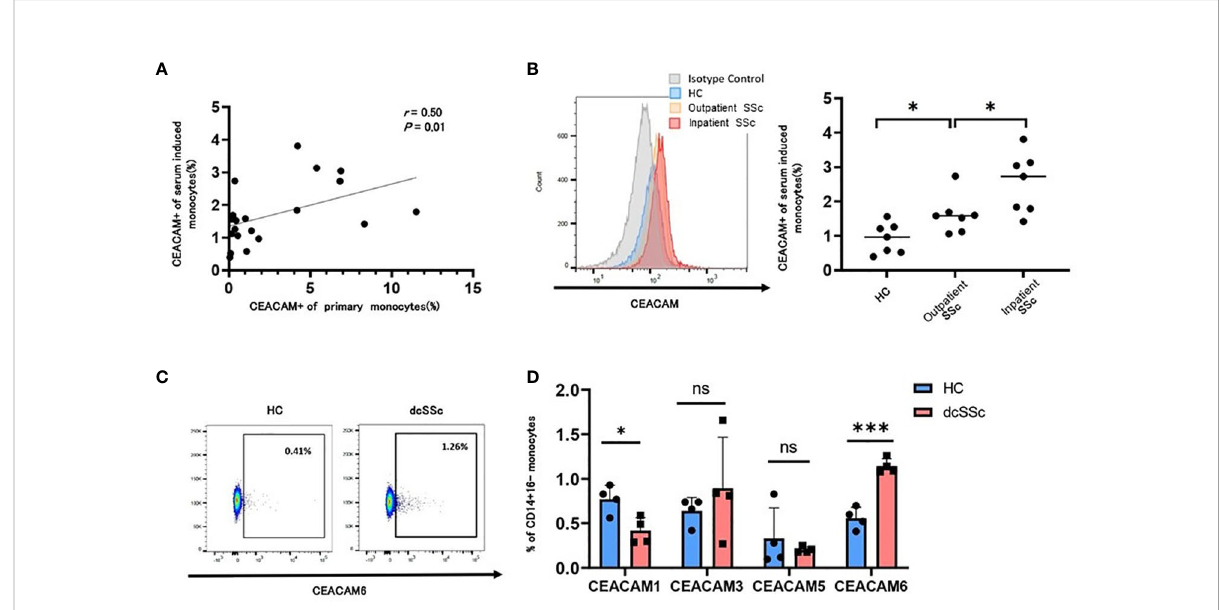
FIGURE 4 SSc serum induced CEACAM6 expression on classical monocytes. CD14+16- monocytes were isolated from a healthy donor and were treated with serum from HCs (n=7) and patients with systemic sclerosis (n=14) for 15 h. The proportion of CEACAM-positive classical monocytes from patients with SSc who provided serum was also analyzed. (A) Dot plots show the correlation between the proportion of CEACAM+ monocytes from a healthy donor treated with SSc serum and that from patients with SSc obtained at the same time as the serum. Statistical analysis was performed using Spearman ’ s rank correlation test. (B) The frequency of serum-induced CEACAM+CD14+16- monocytes was compared among HCs (n=7), inactive SSc (n=7), and active SSc (n=7). Each analysis was performed in duplicates. The left fi gure shows a histogram of CEACAM. (C, D) Data show the frequency of CEACAM1, 3, 5, and 6+ monocytes treated with serum from HCs or patients with dcSSc. Gating of CEACAM6+ monocytes is shown in (C) Data are presented as mean ± standard deviation (SD). P values were calculated using an unpaired t-test. * P < 0.05, *** P <